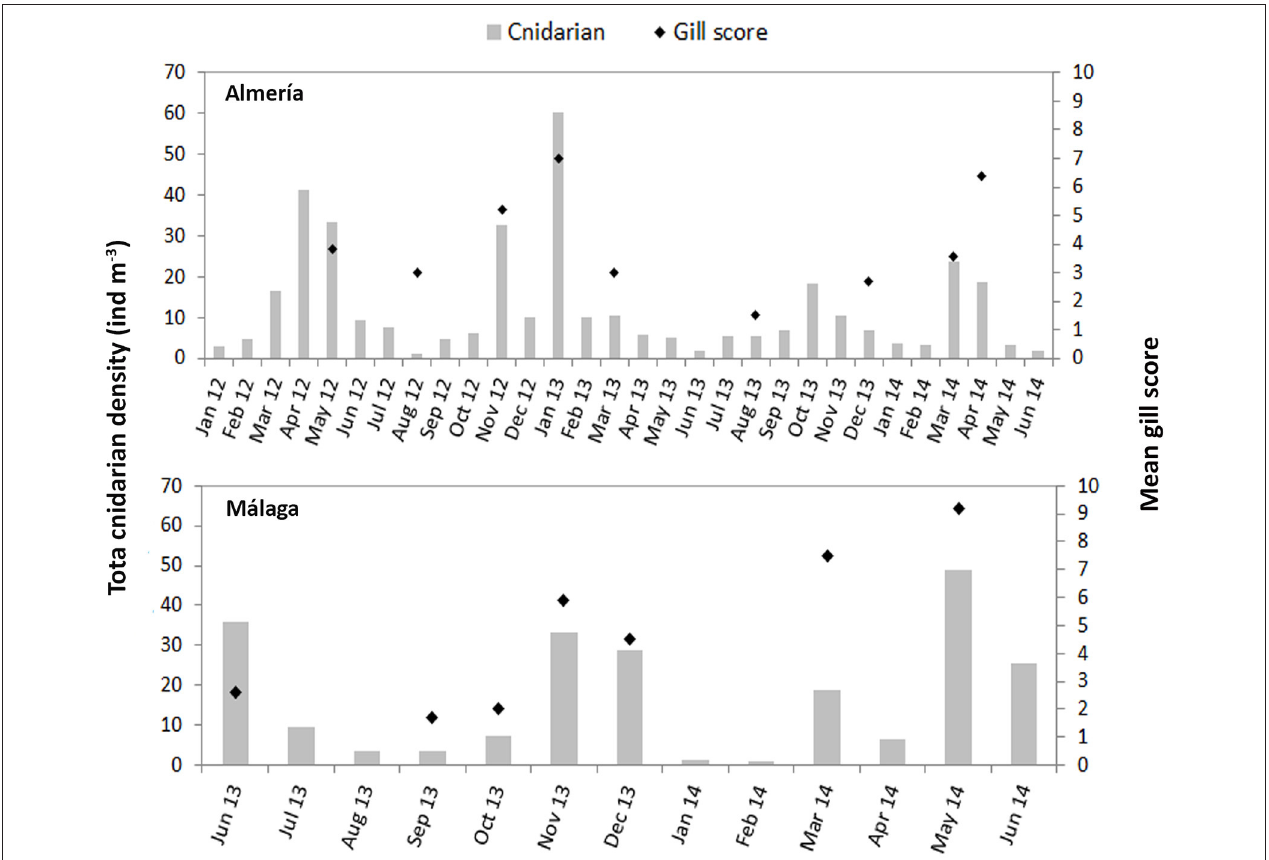
FIGURE 8 | Cnidarian densities and gill scores over time for the Almería and Málaga fish